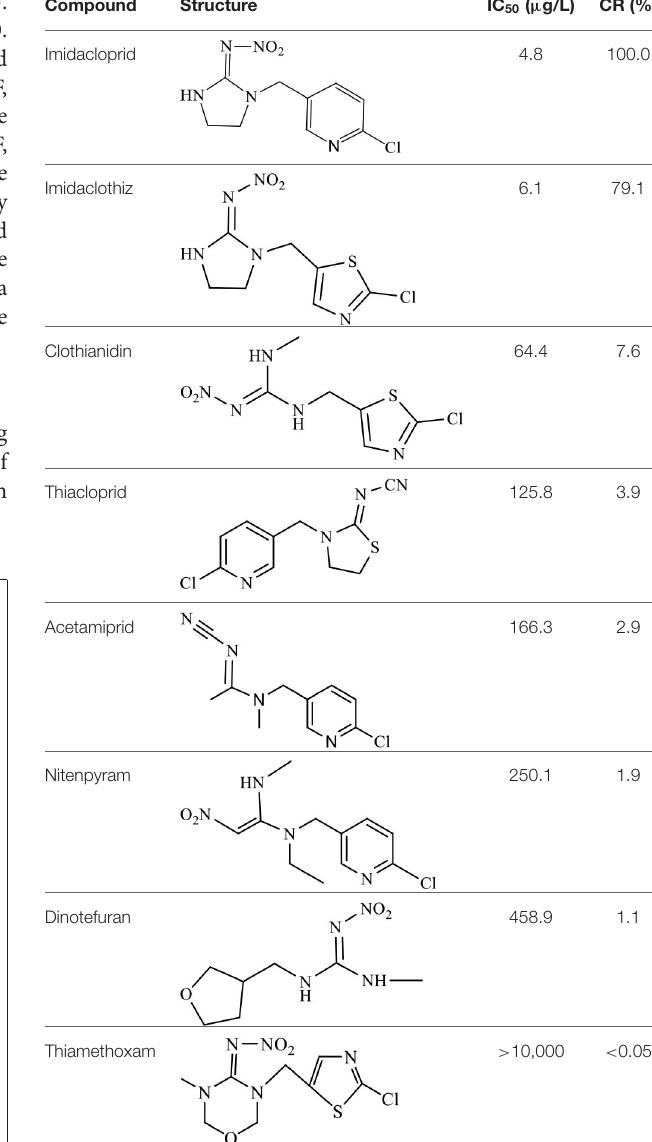
TABLE 3 | Cross-reactivity of IMI toward some of its analogs by